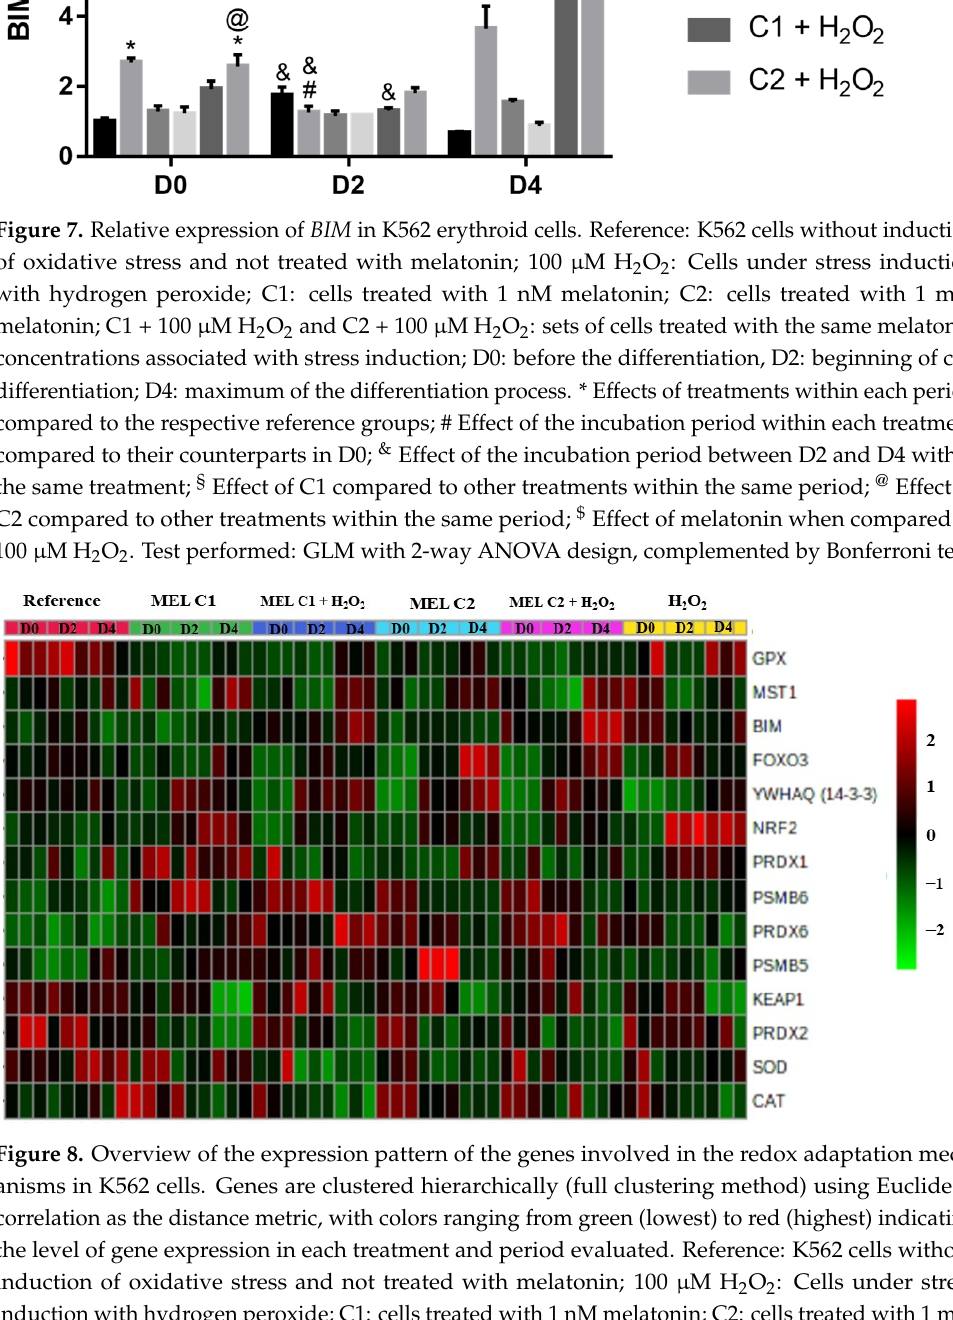
concentrations associated with stress induction; D0: before the differentiation, D2: beginning of cell melatonin; C1 + 100 µ M H 2 O 2 and C2 + 100 µ M H 2 O 2 : sets of cells treated with the same melatonin